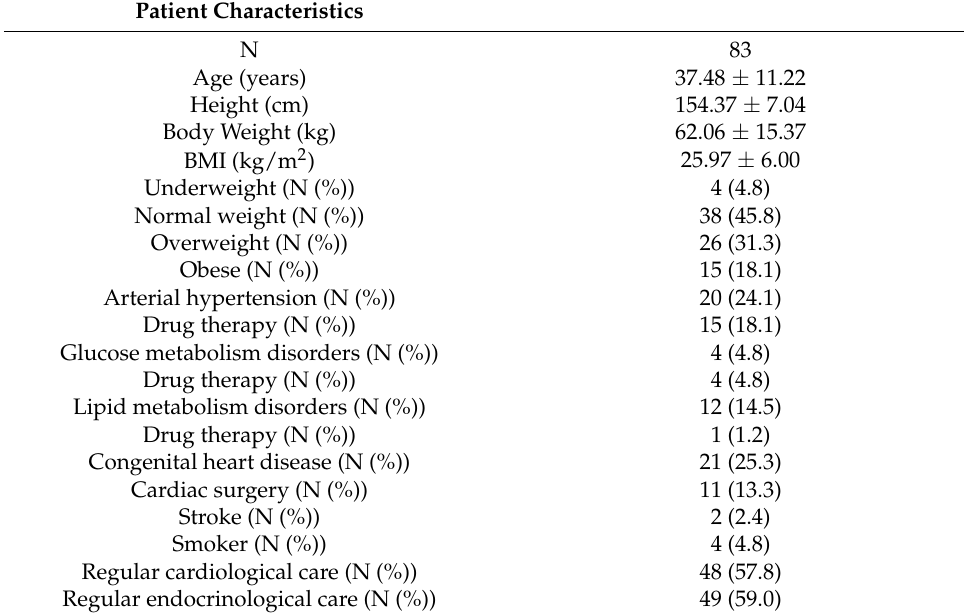
Table 1. Patient characteristics and cardiovascular morbidity of Turner syndrome patients.